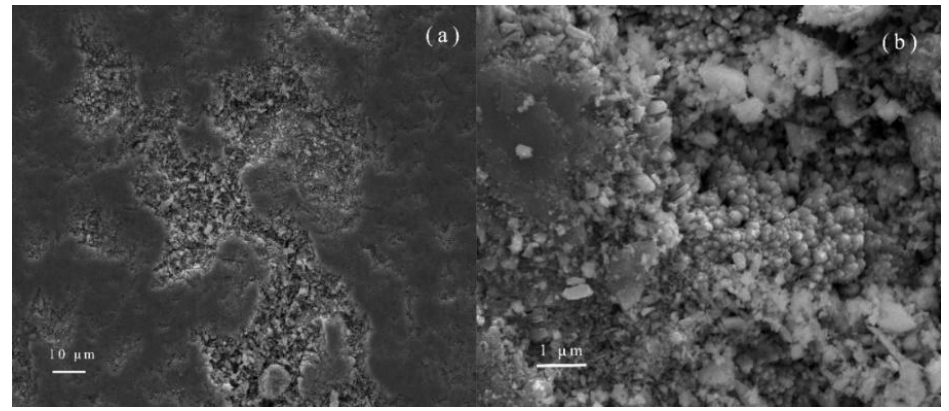
Figure 10. SEM images of the root section of the